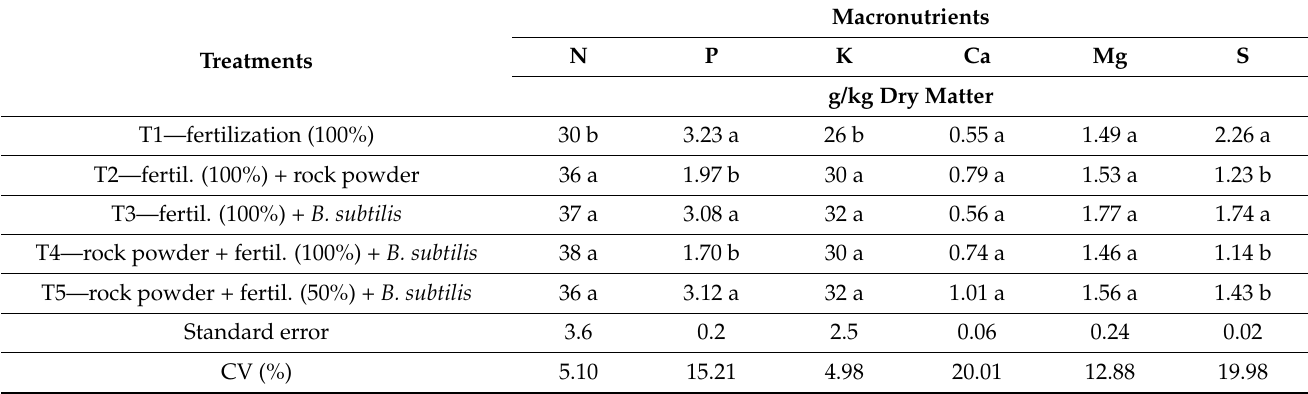
Table 3. Chemical analyses of the macronutrients nitrogen (N), phosphorus (P), potassium (K), calcium (Ca), magnesium (Mg), and sulfur (S) expressed in g/kg of dry matter, performed on maize leaves (40 DAE) with the association of Bacillus subtilis , rock powder, and conventional fertilization (experiment